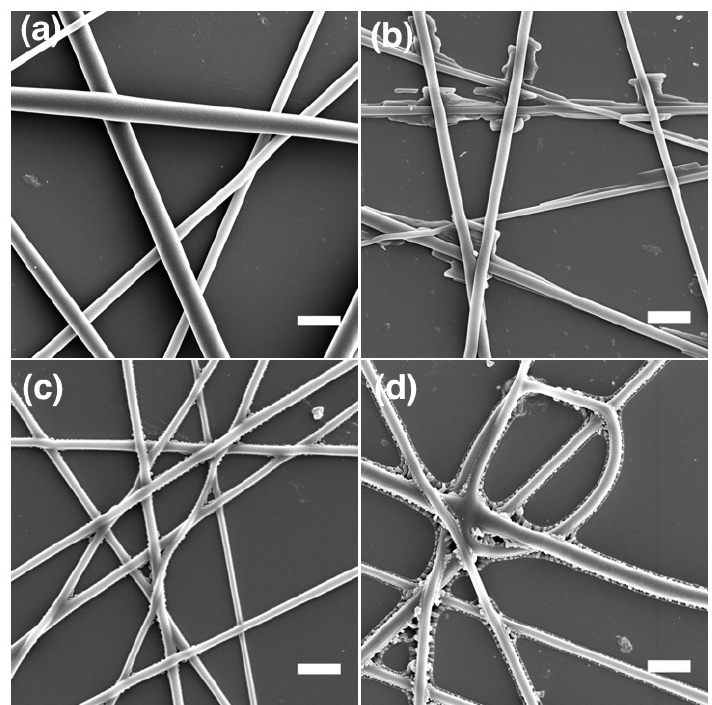
Figure 10. SEM images of LCE-PLA fibers ( a ) without UV and heat exposure; ( b ) heated to 55 ◦ C; ( c ) after UV exposure at 55 ◦ C and ( d ) after UV exposure at 55 ◦ C and subsequent heating to 75 ◦ C, above the clearing transition of the LCE. (scale bars: 10 µ